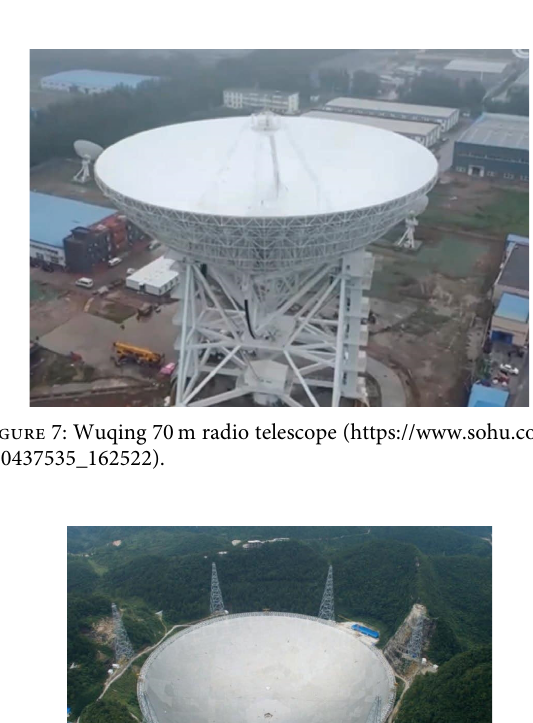
Figure 6: Haoping 40m radio telescope (http://pic.cas.cn/ pic_ntsc_cas/yqfm/201907/t20190709_5337491.html).